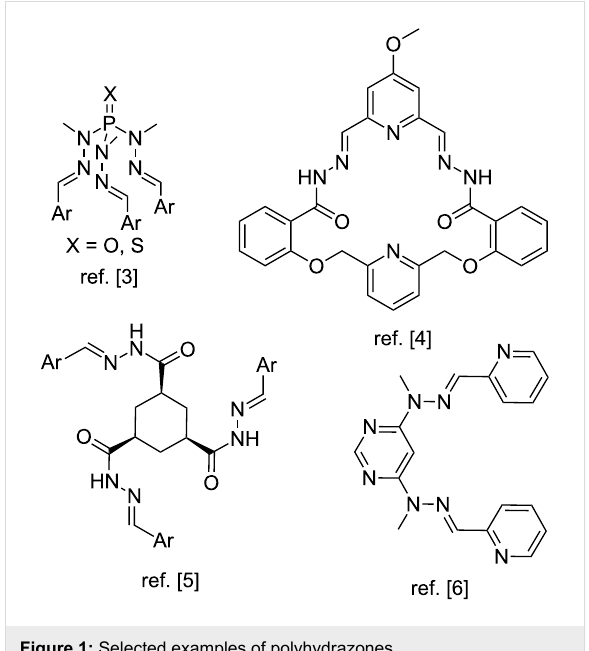
Figure 1: Selected examples of